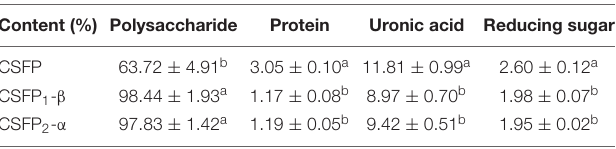
Values represent mean ± standard deviation, and different superscript lowercase letters indicate significance (p < 0.05) in each